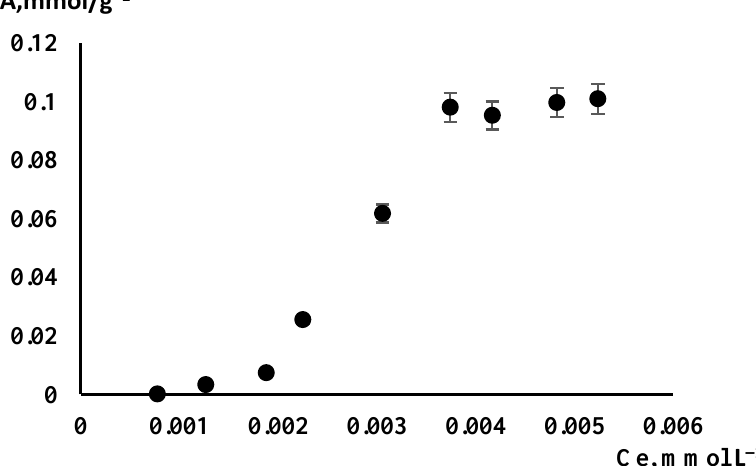
Figure 4. Adsorption isotherm for the sorption of Ag(I) on Sil–Im at 298 K (equilibrium nitric acid concentration 0.1 M, m (Sil–Im) = 0.05 g), (n = 4, p = 0.95).